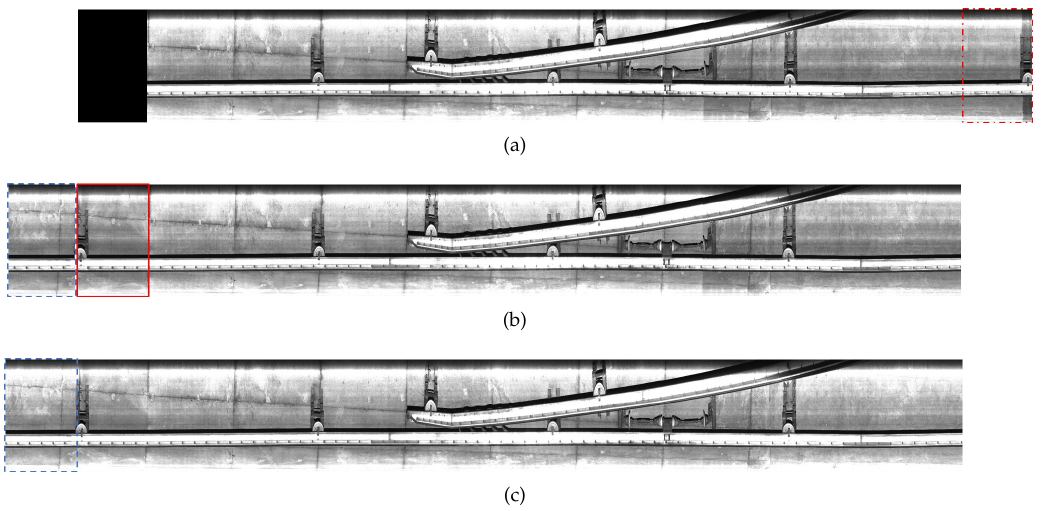
Figure 4. Coarse registration process of the proposed system: ( a ) horizontally transformed image of Figure 3a; ( b ) reconstructed result of ( a ); and ( c ) reconstructed results of Figure 3b,